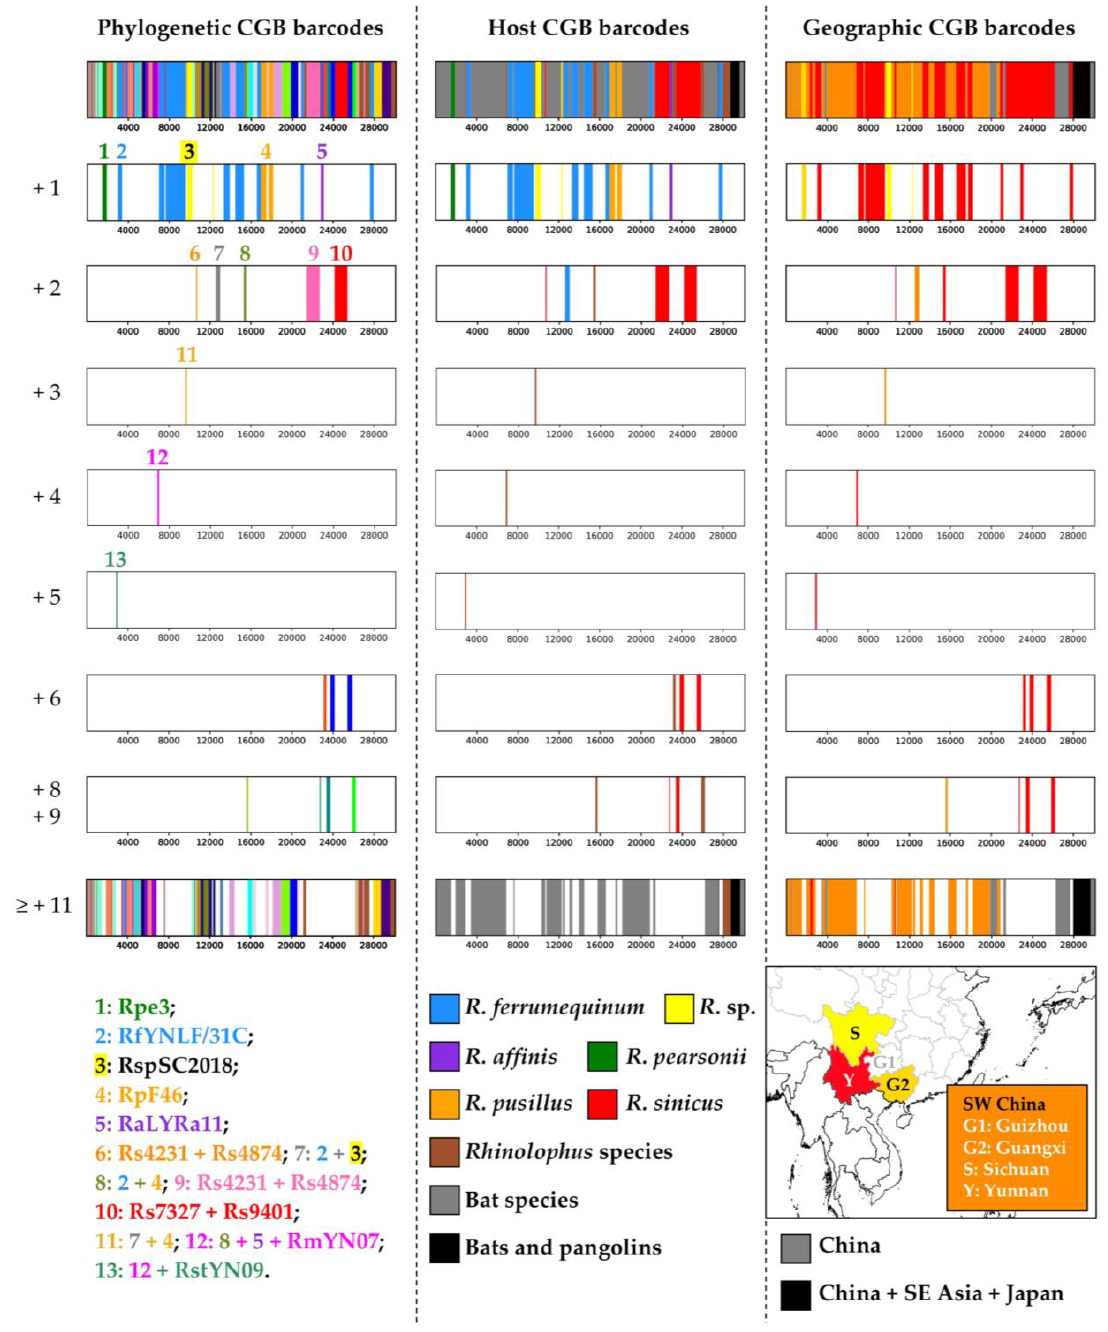
Figure 3. Coloured genomic bootstrap (CGB) barcodes constructed for the common ancestor of SARS-CoV. At the left part of the figure are shown phylogenetic CGB barcodes, in which the best phylogenetic signals (i.e., BBC bipartitions including the fewest number of closely-related viruses) are represented by different colours. To facilitate interpretation, we have also shown versions reduced to the bipartition categories +1 (n = 5 bipartitions including SARS-CoV and another virus), +2 (n = 5 bipartitions including SARS-CoV and two other viruses), +3 (n = 1), +4 (n = 1), +5 (n =1), +6 (n = 2), +8 and +9 (n = 4) and all bipartitions uniting SARS-CoV sequences with at least 11 other viruses (n = 30). The bat sarbecoviruses included in the 13 smallest bipartitions (categories +1 to +5) are detailed at the bottom. Similarly, the full and reduced versions of host and geographic CGB barcodes are shown in the middle and right parts of the figure. The colour codes used for host taxa and geographic areas are provided at the bottom.